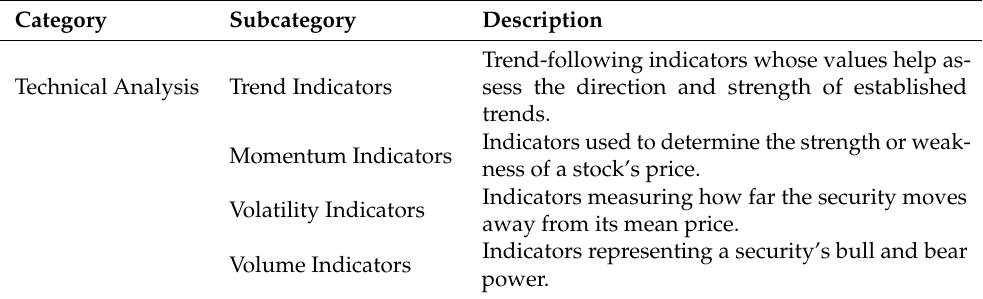
Table 2. Cont . Category Subcategory Description Trend-following indicators whose values help as- Technical Analysis Trend Indicators sess the direction and strength of established trends. Indicators used to determine the strength or weak- Momentum Indicators ness of a stock’s price. Indicators measuring how far the security moves Volatility Indicators away from its mean price. Indicators representing a security’s bull and bear Volume Indicators